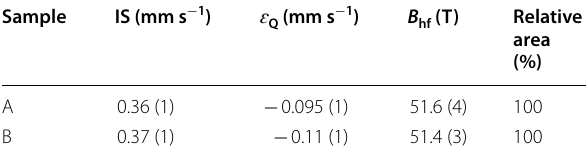
Table 2 Mössbauer parameters IS, ( ɛ samples A and B (Reprinted with Permission from [56]. Copyright, American Chemical